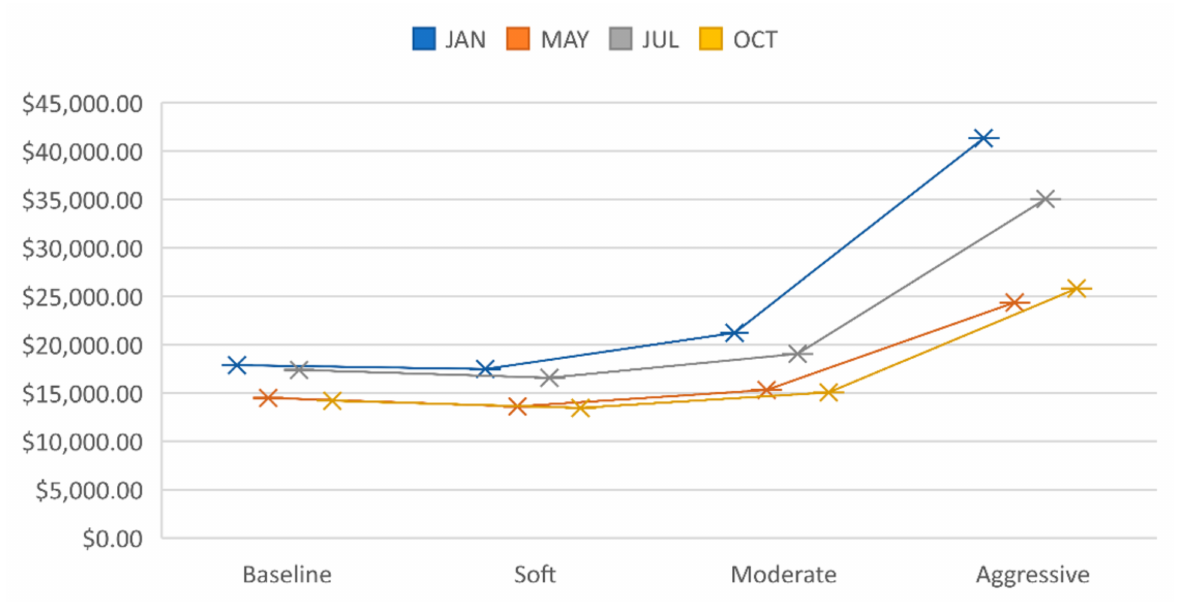
Figure 6. Utility monthly turnover in USD.